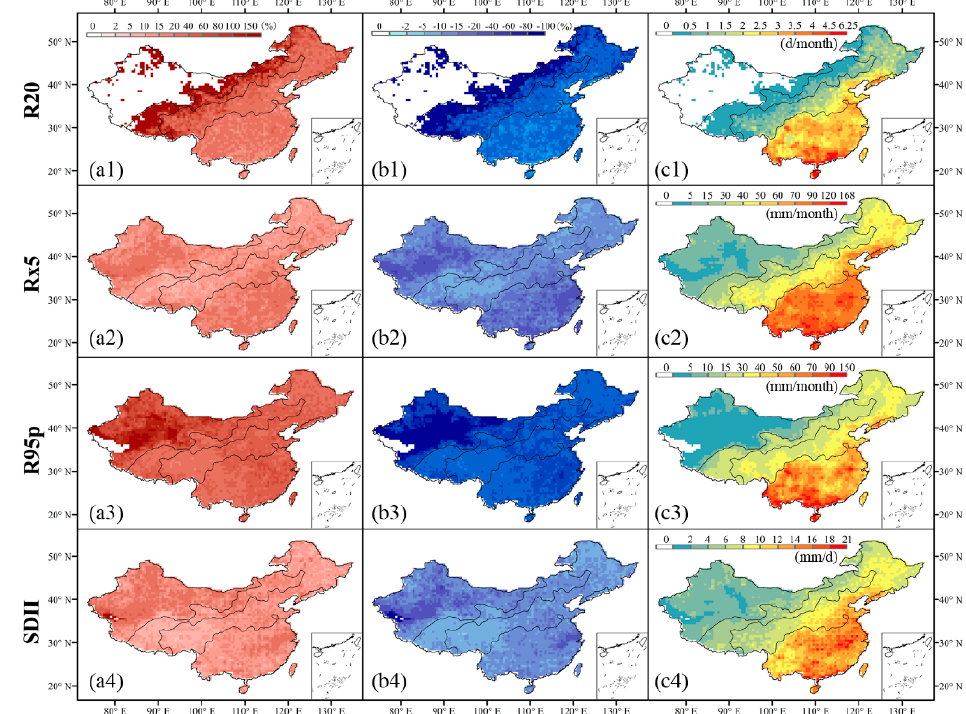
Figure 7. Spatial distribution of the annual mean anomaly percentages (positive percentage: ( a1 – a4 ); negative percentage: ( b1 – b4 ) and annual mean values ( c1 –c 4 ) of four precipitation indices in JJA.